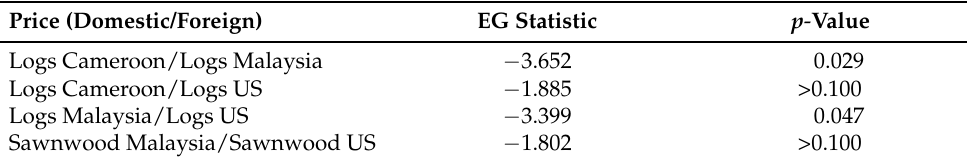
Table 4. Engler–Granger cointegration test for forest products markets pass-through